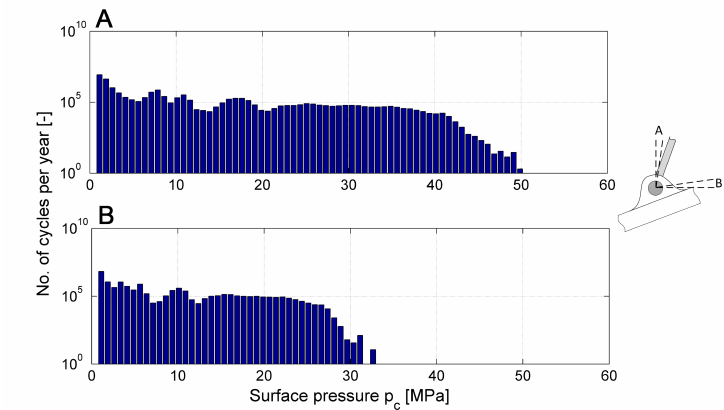
Figure 9. Example of a fatigue surface pressure range spectrum at two different locations at the bearing ring (Segments A and B ). The diameter of the inner bearing ring is in this example 100